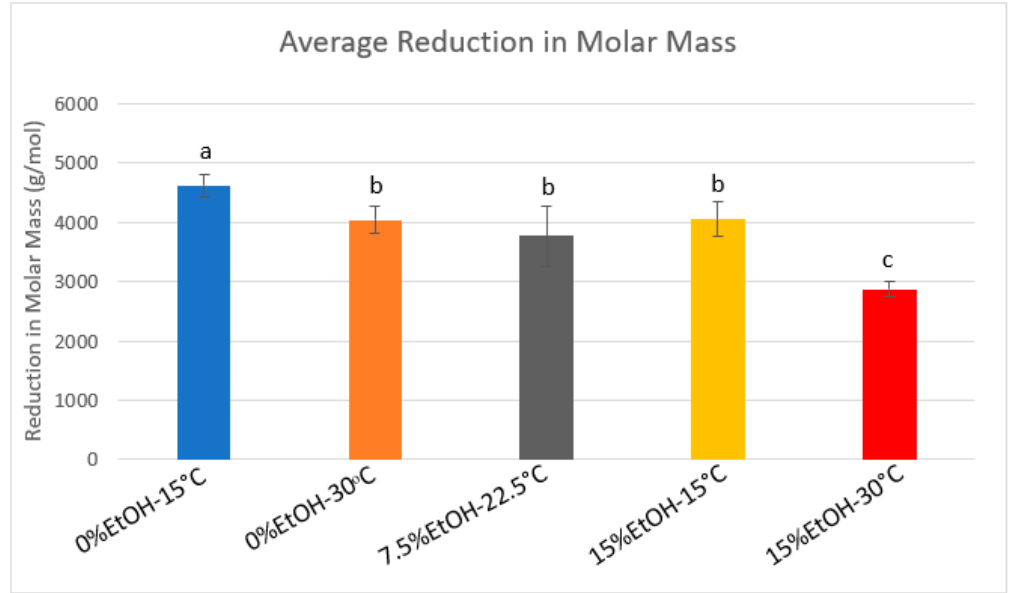
Figure 4. Average reduction in molar mass of PA solution due to adsorption. Values calculated from average decrease between control and trial sample molar mass ( n = 9). Significant differences denoted by lowercase letters ( p < 0.05).